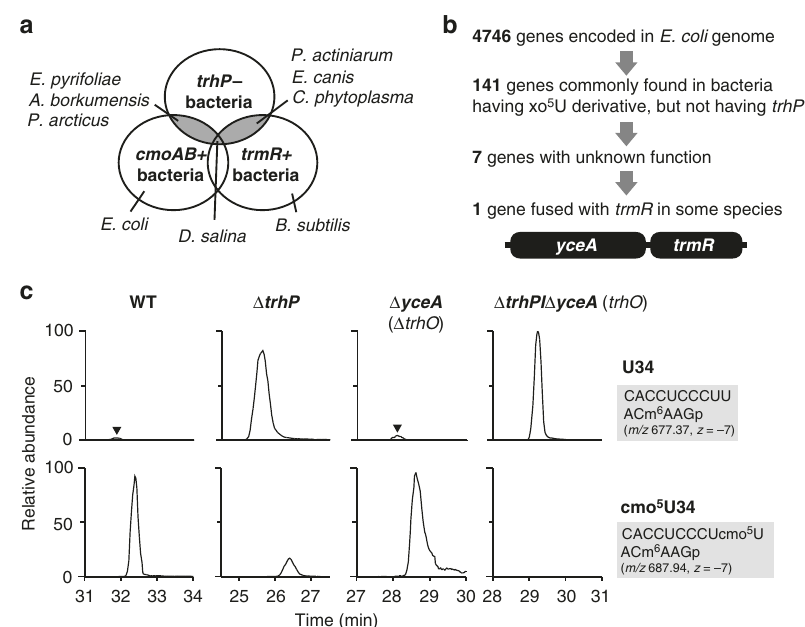
Fig. 3 Identi fi cation of trhO responsible for tRNA hydroxylation. a Venn diagram depicts a group of organisms that have cmoAB or trmR homologs but no trhP homologs. Erwinia pyrifoliae , Alcanivorax borkumensis , and Psychrobacter arcticus harbor cmoAB but not trhP ; Pontibacter actiniarum , Ehrlichia canis , and Candidatus phytoplasma harbor trmR but not trhP ; and Dactylococcopsis salina has both cmoAB and trmR but not trhP . b Comparative genomics approach used to narrow down the candidate gene that bypasses ho 5 U34 biogenesis. In Phytophthora sojae , Phytophthora ramorum , and Phaeodatylum tricornutum , yceA and trmR are fused as a single gene. c Mass-spectrometric analysis of the wobble modi fi cation in E. coli tRNA Val1 isolated from WT (left panels), Δ trhP (middle left panels), Δ yceA (middle right panels), and Δ trhP / Δ yceA (right panels) strains. XICs show anticodon-containing fragments of tRNA Val1 with U34 (upper panels) and cmo 5 U34 (lower panels). Black arrowheads indicate peaks corresponding to U34-containing fragments detected in the WT and Δ yceA . Sequence, m/z value, and charge state of each fragment are shown on the